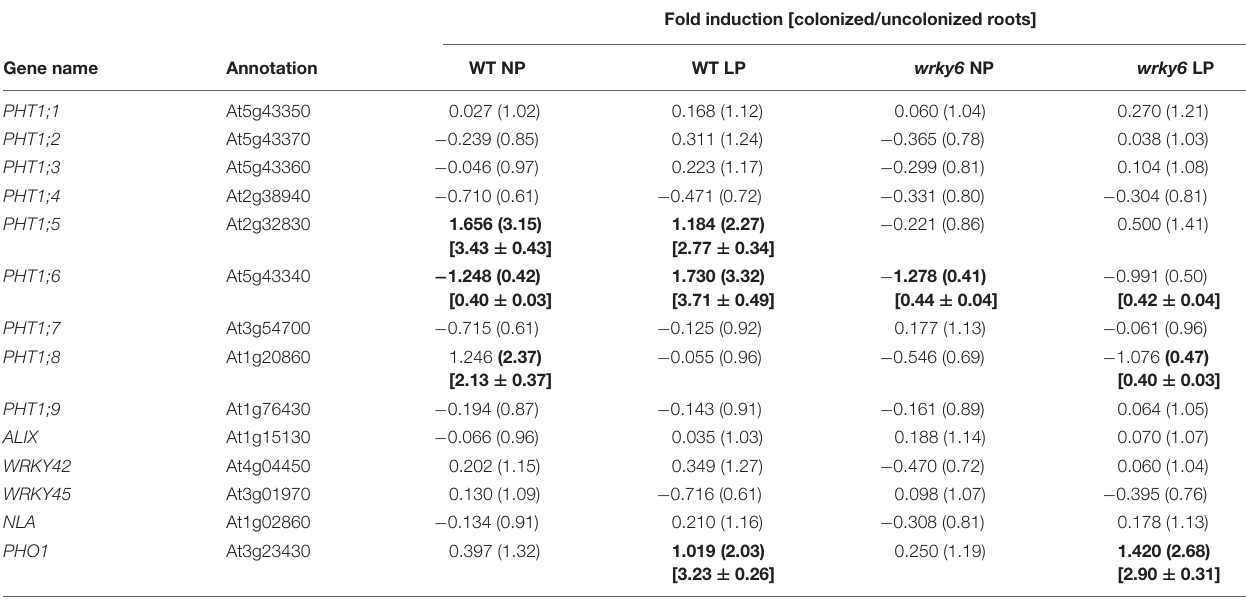
TABLE 1 | Regulation of the 9 PHOSPHATE TRANSPORTER1 ( PHT1 ) genes and genes for regulatory proteins involved in PHT1 gene and PHT1 protein regulation by Piriformospora indica in WT and wrky6 roots under NP and LP conditions. Fold induction [colonized/uncolonized